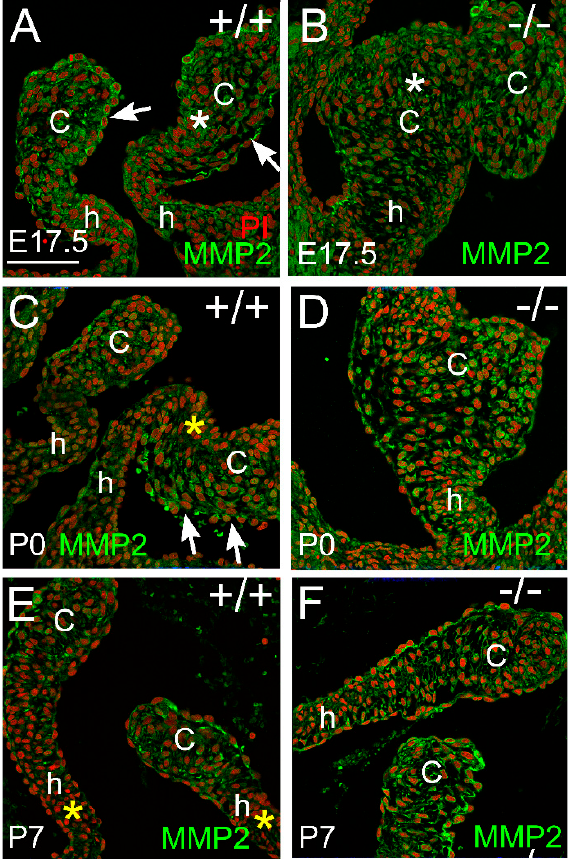
Figure 4. MMP2 localization is present in the endocardium and valvular interstitial cells of developing car- diac valves. MMP2 immunolocalization (green) at embryonic day 17.5 (E17.5; A , B ), postnatal day 0 (P0; C , D ), and postnatal day 7 (P7; E , F ) in wild type (+/+; A , C , E ) and Adamts5 − / − PV ( − / − ; B , D , F ). c—valve cusp; h—valve hinge region. Red—propidium iodide. Solid white arrows—endocardial expression of MMP2; white asterisk—localization of MMP2 throughout the VICs; yellow asterisk—region of VICs devoid of MMP2 localization. Bar in ( A ) = 150 μ m and applies to ( B – F ).